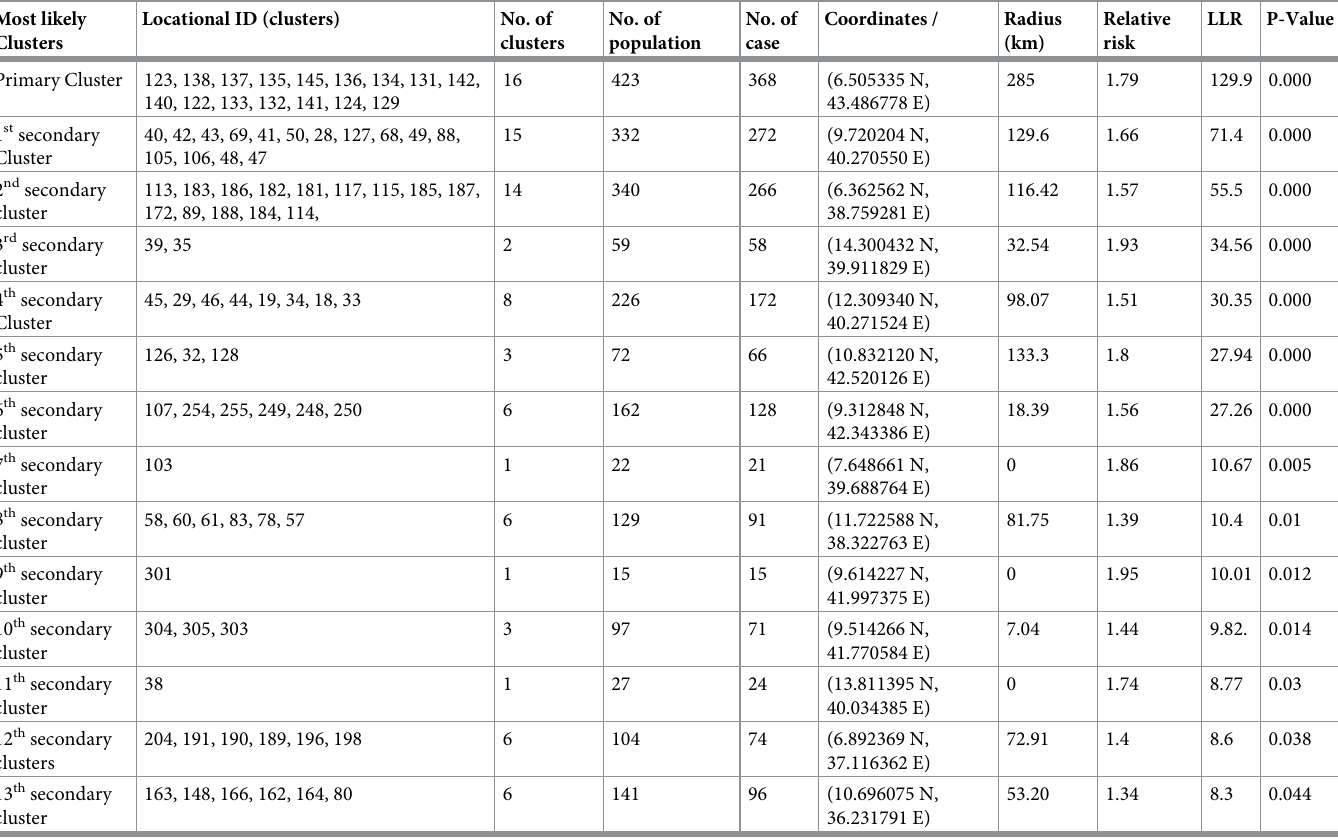
Table 2. Show that the most likely clusters from a purely spatial scan statistic (Bernoulli model) of high rate of home delivery among 15–49 age women who had live births in the last five years preceding EDHS 2019 survey. Most likely